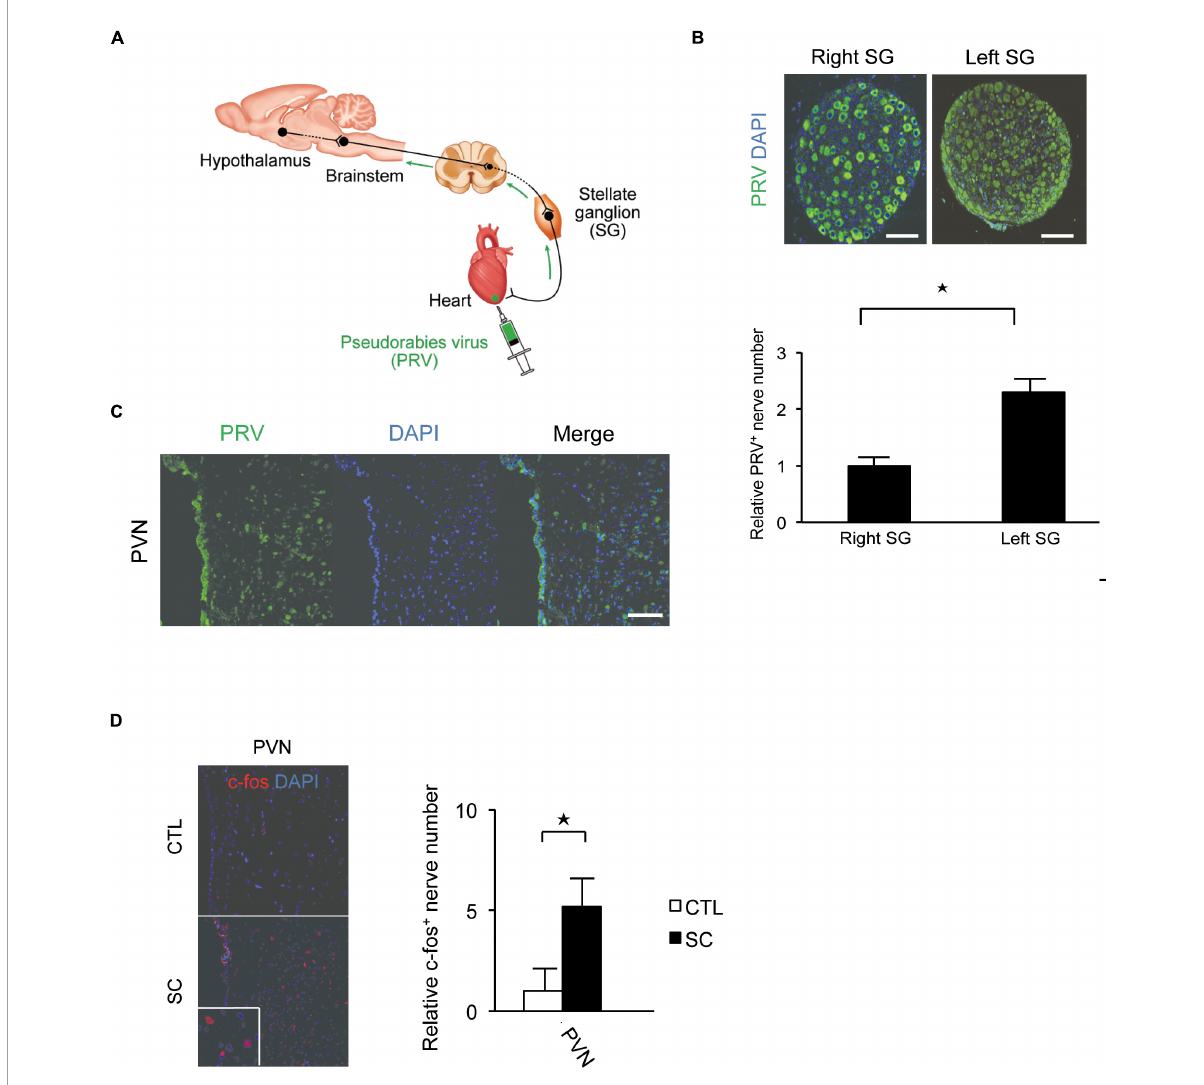
FIGURE2 Pseudorabies virus (PRV) staining of the central portions of sympathetic nerve fibers innervating the apex of the left ventricle. (A) Schema of retrograde labeling by PRV. SG, stellate ganglion. (B) Neurons were labeled by PRV. More neurons were labeled by PRV in the left SG than in the right SG. DAPI, 4 (cid:48) ,6 (cid:48) -diamidino-2-phenylindole. (C) PRV staining revealed that the central portion of the cardiac sympathetic nerve originated mainly in the paraventricular hypothalamic nucleus (PVN). Scale bars: 50 µ m (B) ; 100 µ m (C) . (D) Immunofluorescence staining for c-fos in the PVN of the control and SC groups. Quantitative analysis of c-fos-positive cells is shown ( n = 5). * p <